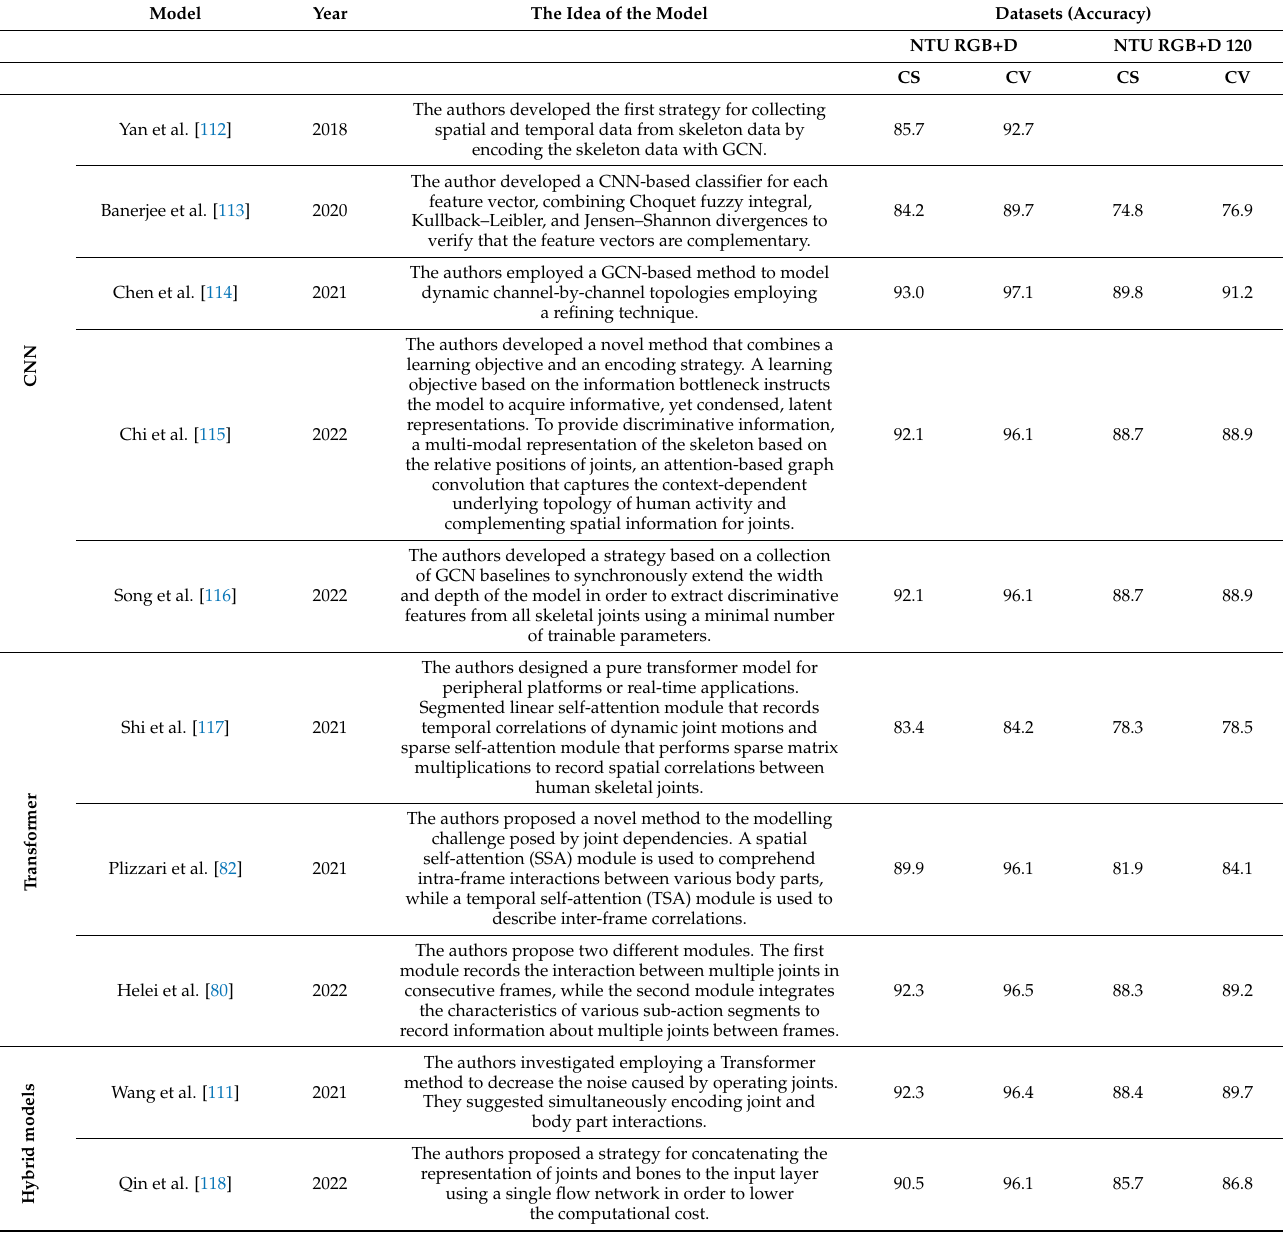
Table 3. Skeleton modality comparison of CNN, Transformer, and Hybrid model techniques for action recognition on the datasets NTU-RGB+D 60 [84] and NTU-RGB+D 120 [85] in terms of the accuracy according to the Cross-Subject Evaluation (CS) and Cross-View Evaluation